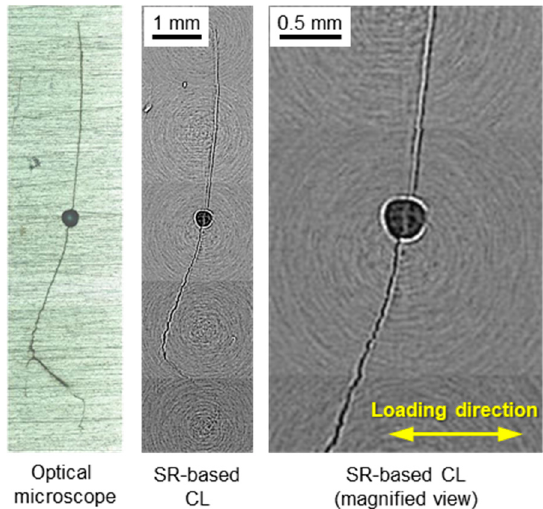
Figure 12. The fatigue crack on the sample surface.